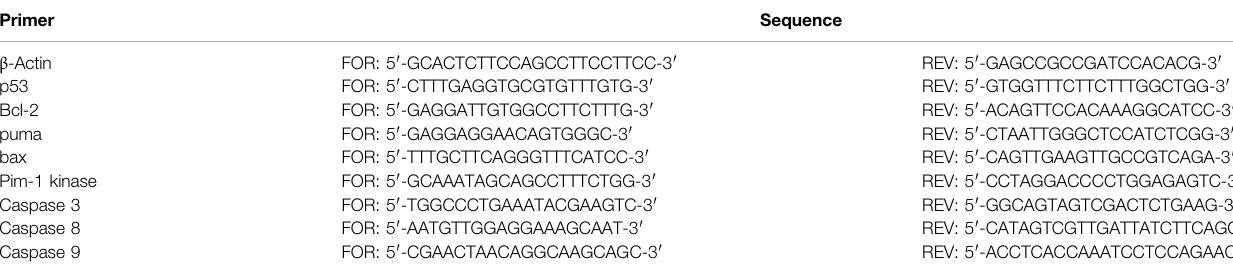
TABLE 3 | Primer sequences in forward and